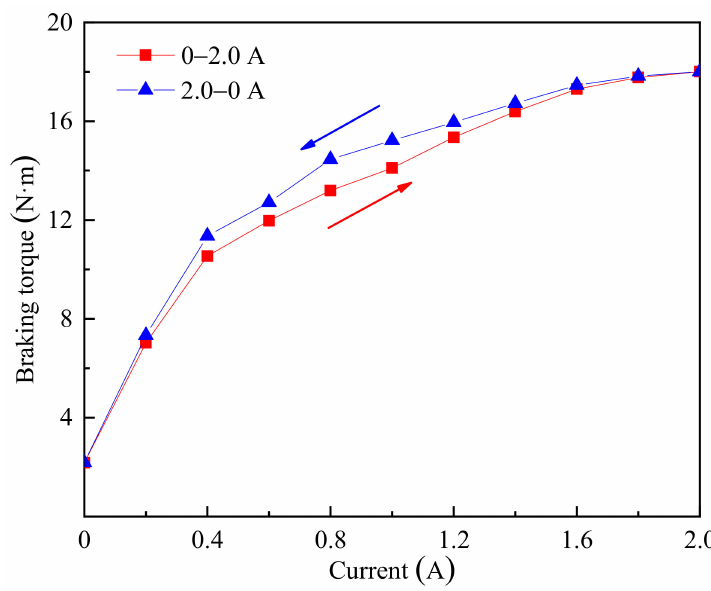
Figure 16. Hysteresis curve of braking